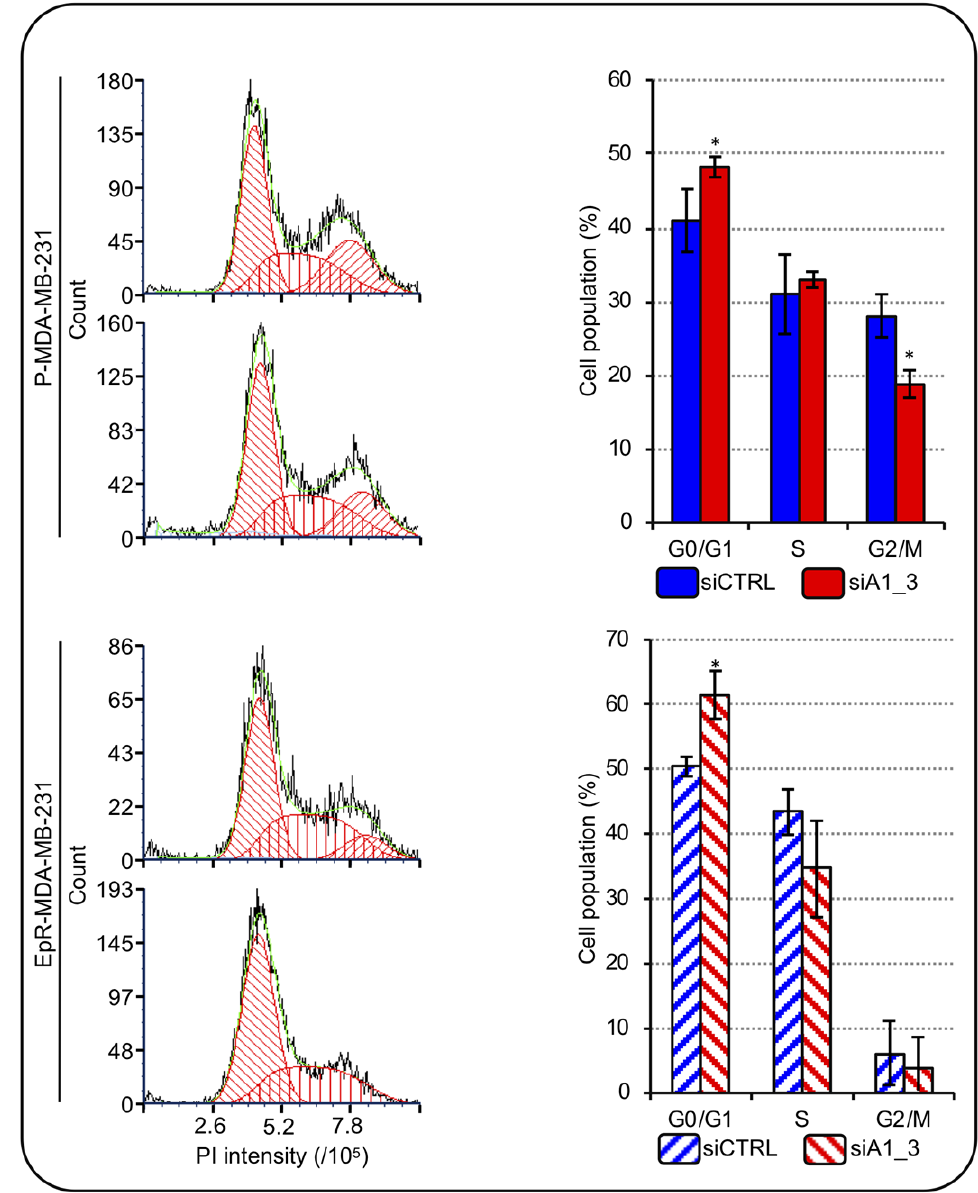
Figure 8. HMGA1 depletion influences EpR-MDA-MB-231 cell-cycle progression. Representative images showing the staining with PI of P-MDA-MB-231 and EpR-MDA-MB-231 cells both silenced for HMGA1 (siA1_3) or for no-target with the control siRNA (siCTRL) (left part). The histogram graphs refer to the relative percentage count of P-MDA-MB-231 and EpR-MDA-MB-231 cells in G1-, S- and G2-M-phase of cell-cycle for both conditions (siCTRL and siA1_3) analyzed (right part). Bars indicate the mean. Standard deviations are shown ( n = 3). Statistical significance was assessed with Student’s t -test (*: p ≤ 0.05).